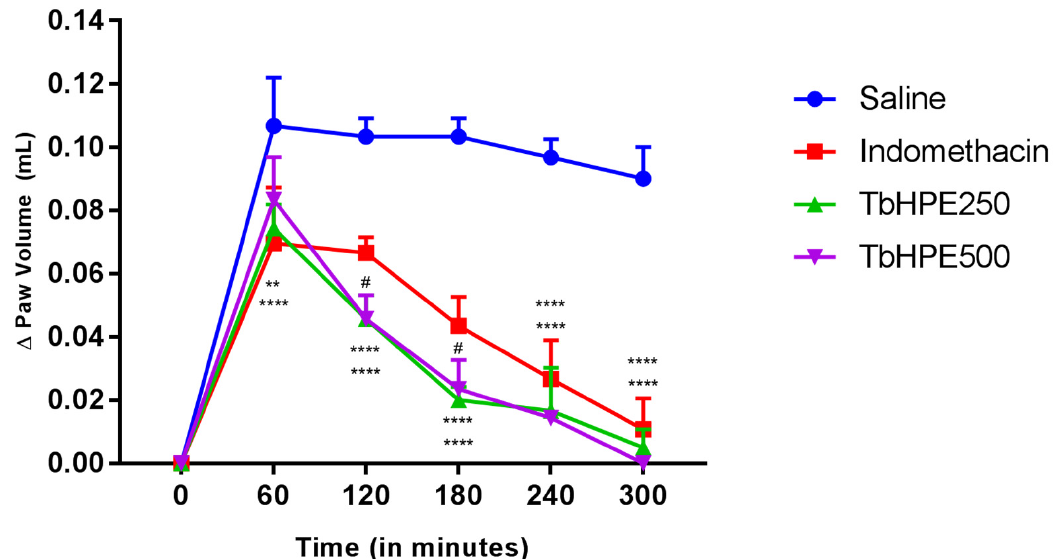
Figure 2. E ff ects of oral treatment with hydroethanolic pollen extract collected by Scaptotrigona a ffi nis